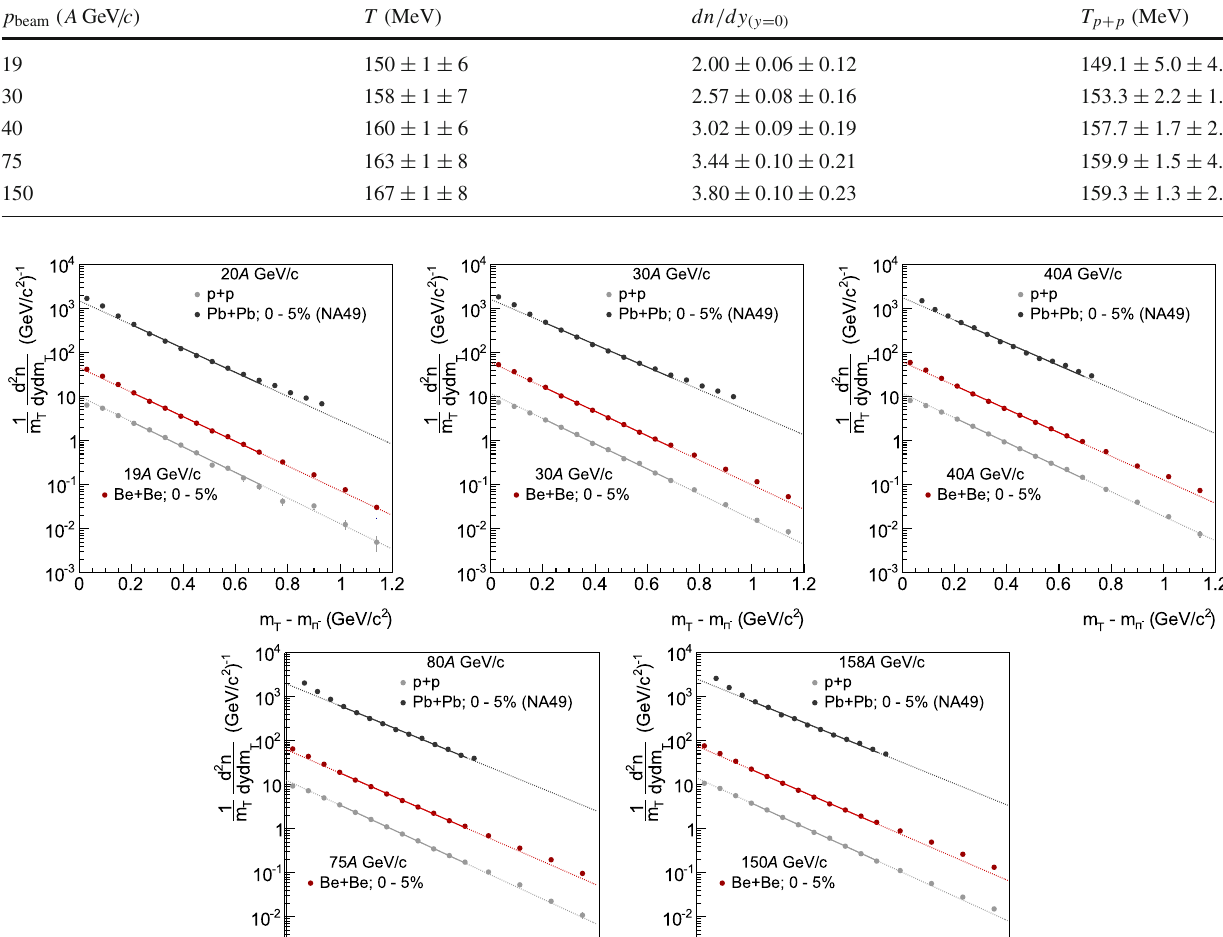
Table 3 Inverse slope parameter T near mid-rapidity fitted in the inter- val 0 . 2 < m T − m π < 0 . 7 GeV and mid-rapidity yield dn / dy of π − mesons in the 5% most central Be + Be collisions. For comparison